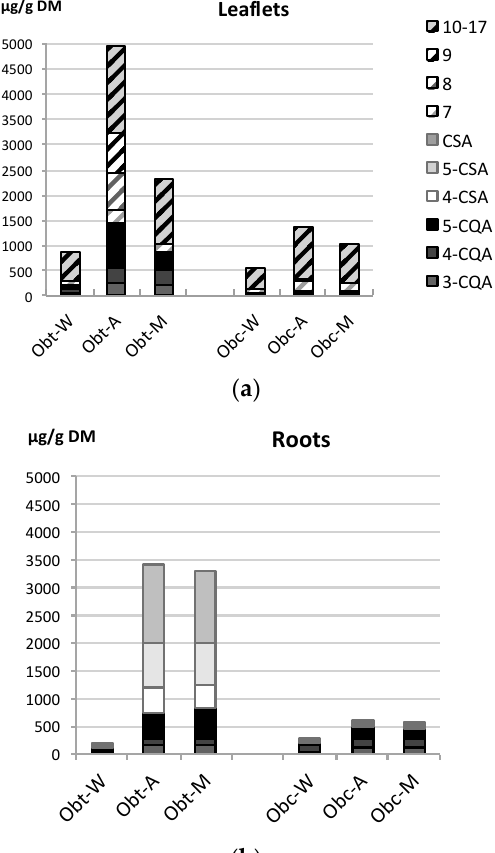
Figure 3. Chemical composition of ( a ) leaflet extracts and ( b ) root extracts of Oenocarpus bataua and Oenocarpus bataua . Obt: Oenocarpus bataua ; Obc: Oenocarpus bacaba ; W: water; A: acetone/water: 70/30; M: methanol/water: 70/30; CQA: caffeoylquinic acid; CSA: caffeoylshikimic acid (for identification of the compounds 7 to 17, see Table 4); n = 3 biological replicates.